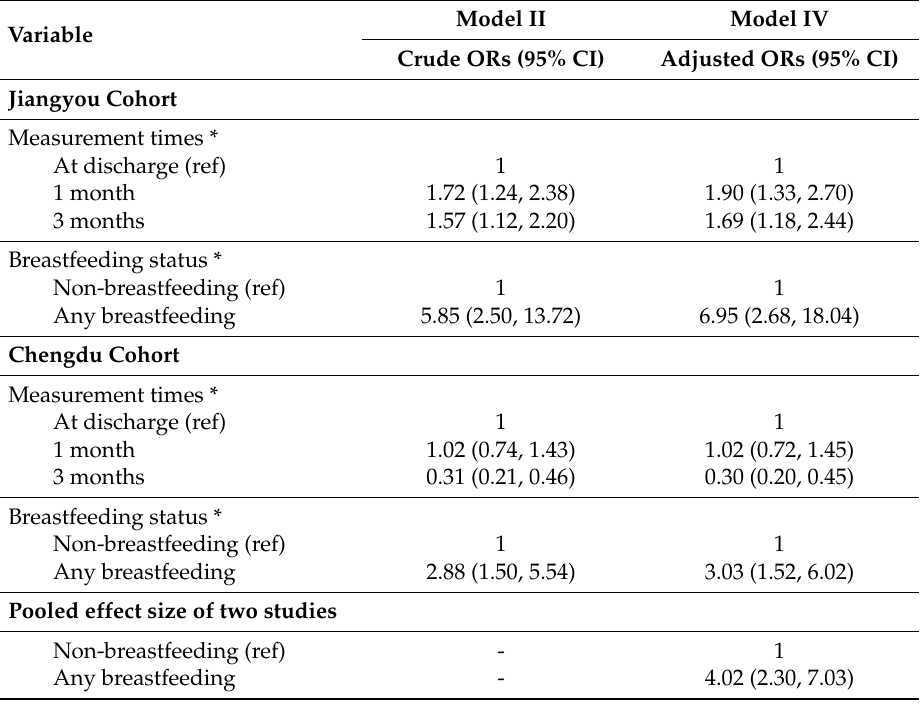
Table 3. Association between breastfeeding status and calcium supplementation